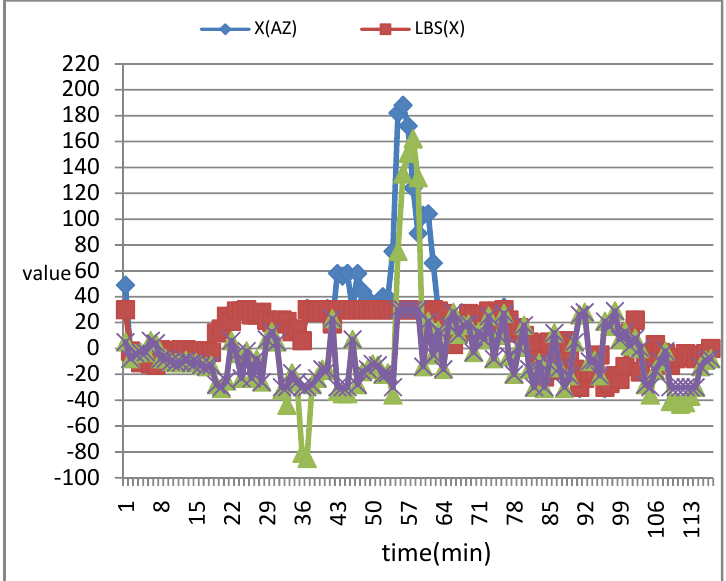
Figure 11. Comparison of LBS control and PID